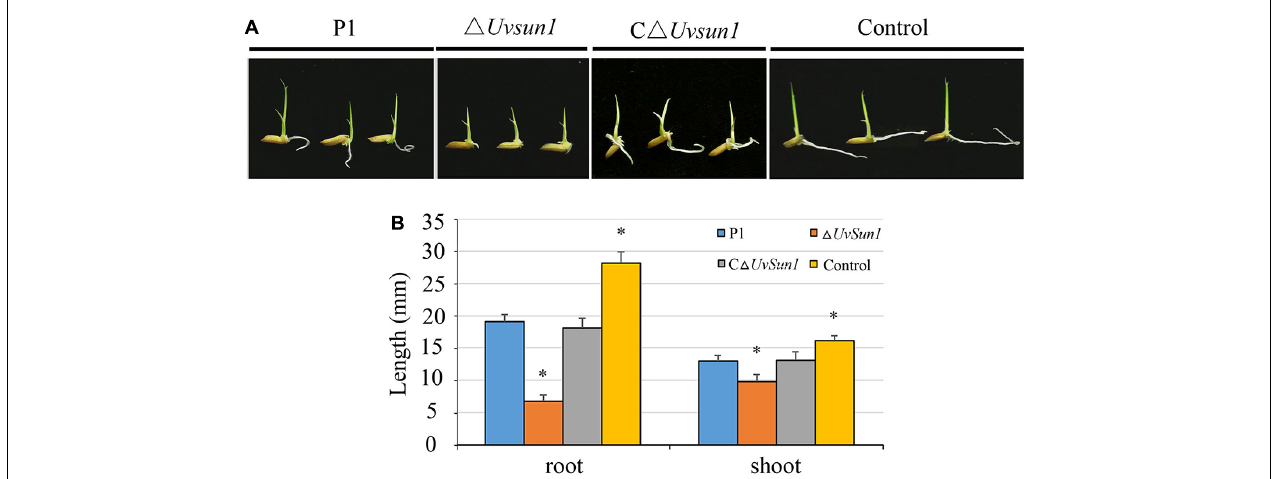
FIGURE 6 | Culture filtrates of (cid:49) Uvsun1 mutants showed increased inhibition of rice seed germination. (A) Grains were germinated in the presence of the filtrate of P1, (cid:49) Uvsun1 , C (cid:77) Uvsun1 or uninoculated YT after 5 days of culture. (B) Quantification of root and shoot lengths of the seedling. Data represent means ± SD from three independent experiments. Asterisks indicate significant differences (one-way ANOVA, ∗ p < 0.05).